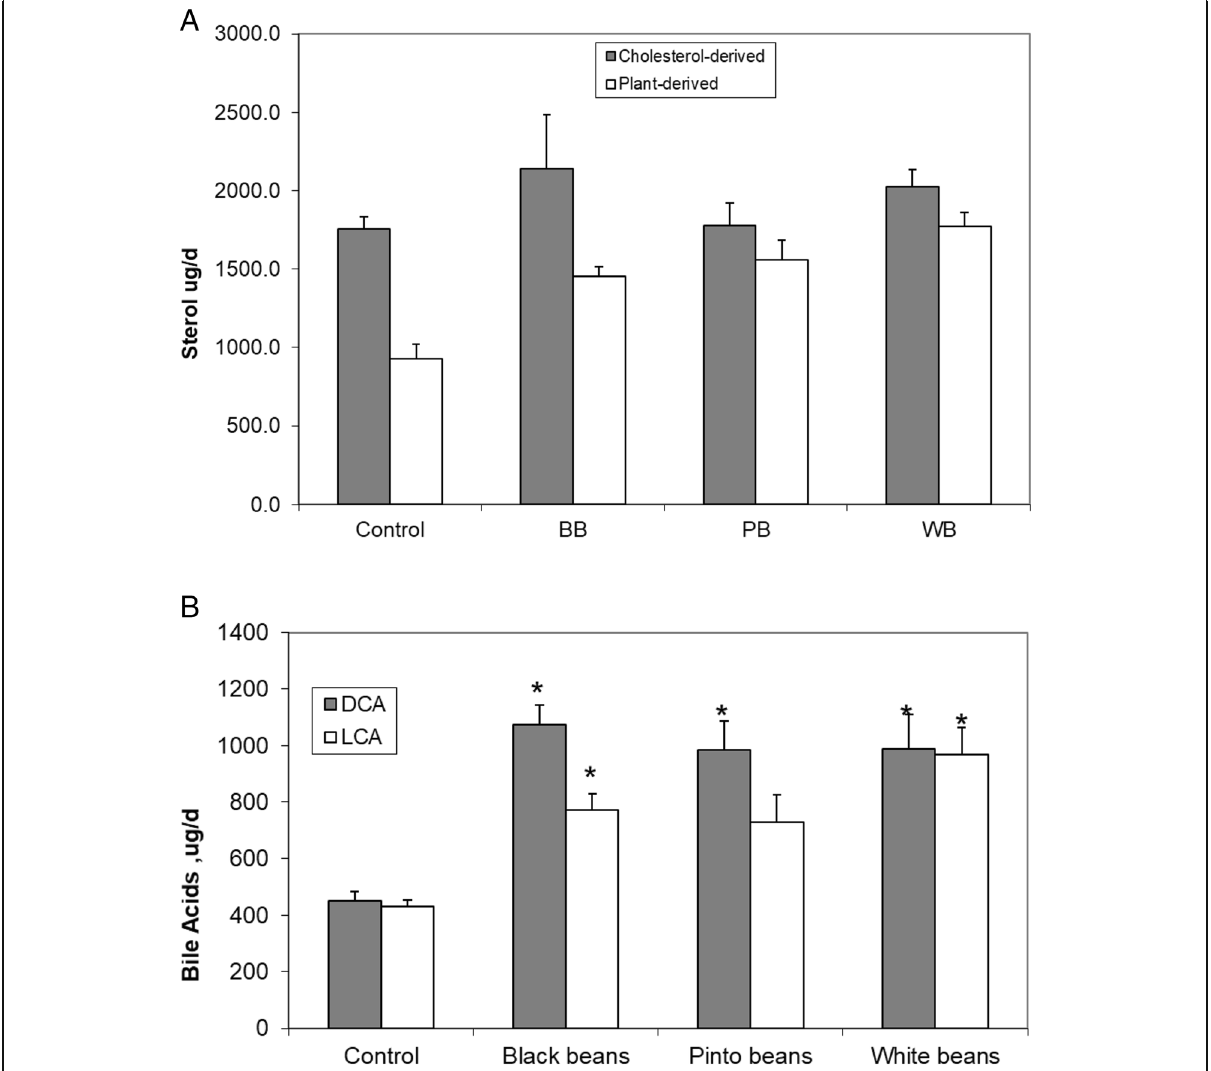
Fig. 2 a Fecal sterols in hamsters fed the high fat diet supplemented with cholesterol, butter and corn oil as sources of sterols. Animal derived sterol are derived from cholesterol and cholesterol in butter, and vegetable sterols and stanols are mainly from sitosterol and campesterol